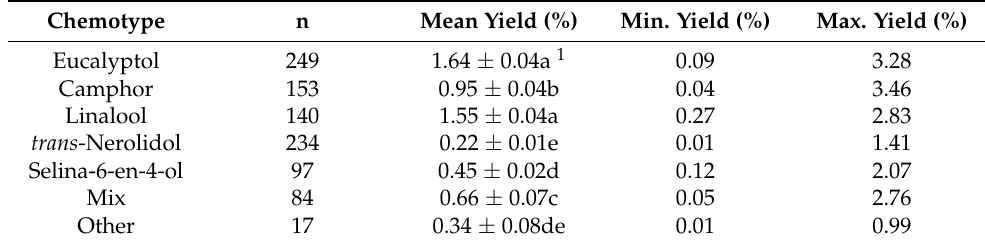
Table 4. The quantity and oil yield of each